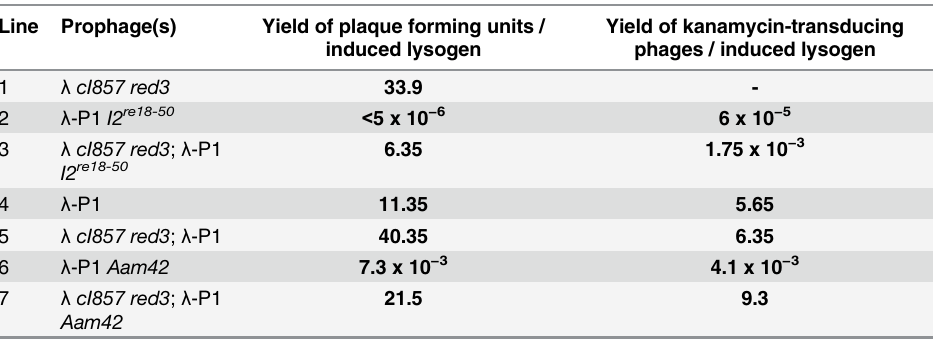
phages were titered with C600( λ + ) as the recipient. A repeat experiment gave equivalent